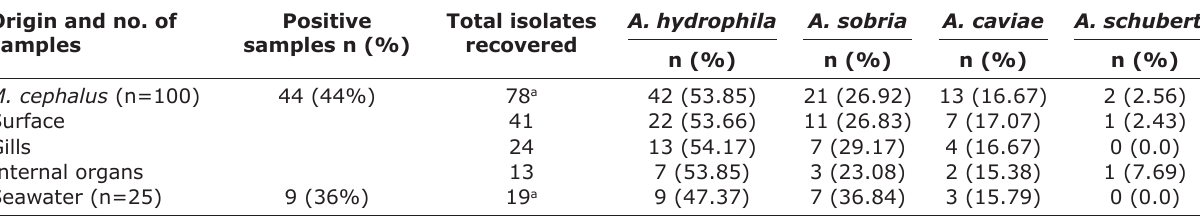
Table-2: Identified Aeromonas spp. strains from M. cephalus and seawater. Origin and no. of samples